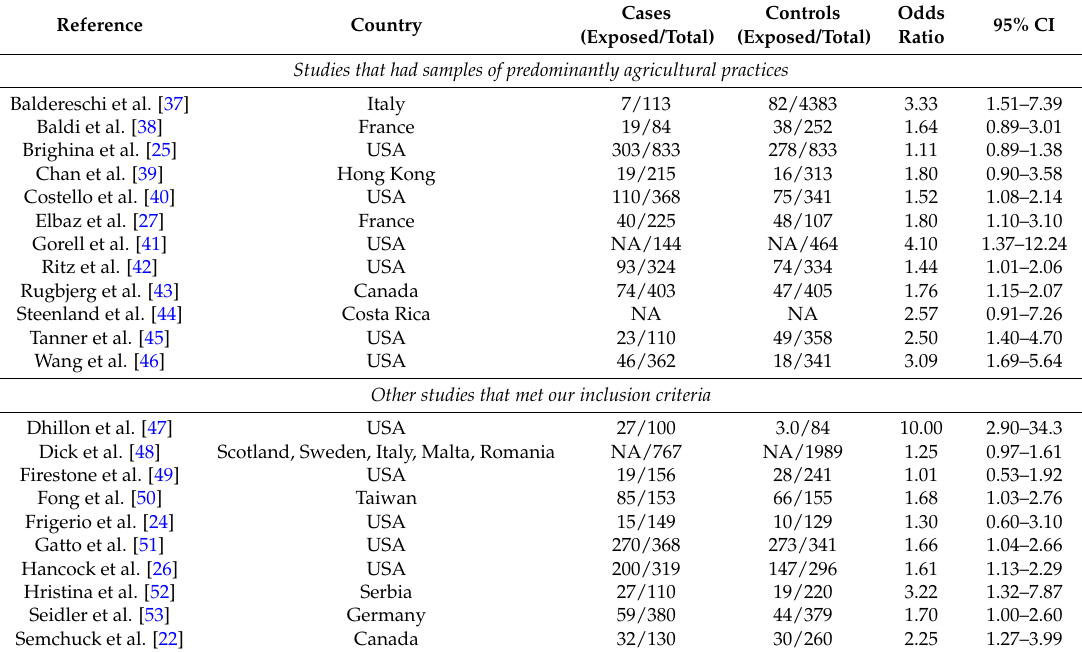
Table 2. Studies included in the